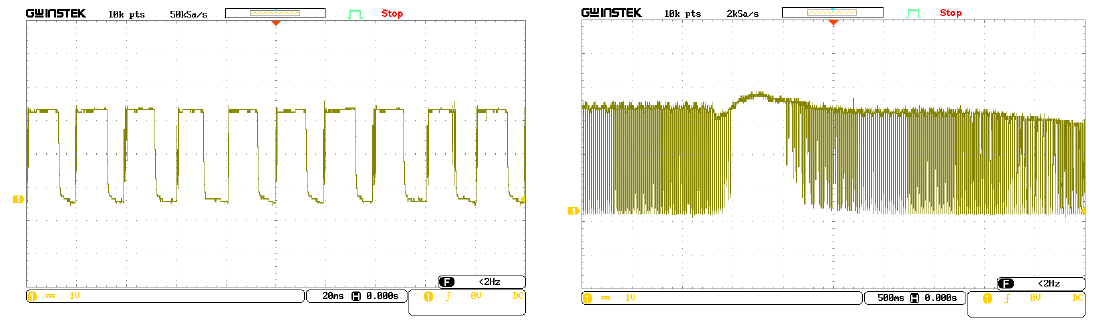
Figure 13. Working waveform of the barometric pressure sensor when the power was supplied by vibration energy.